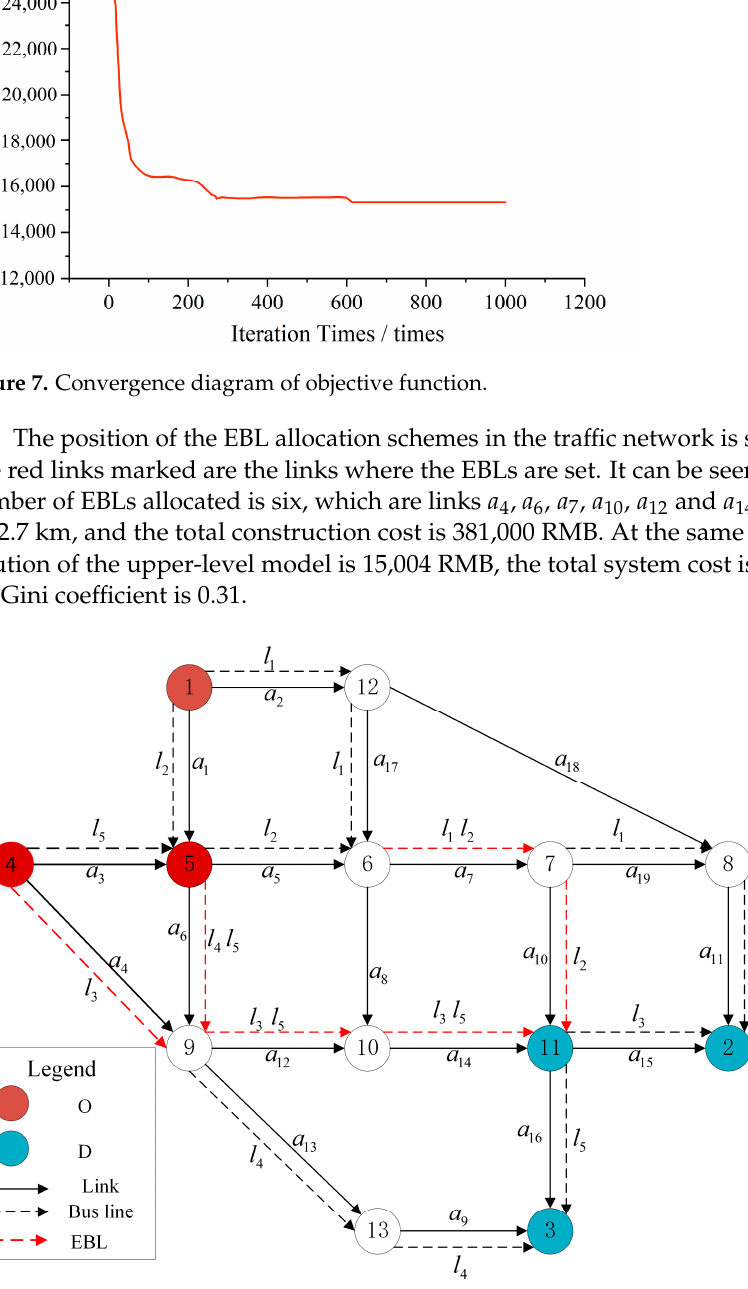
Table 6. Comparative analysis of different allocation